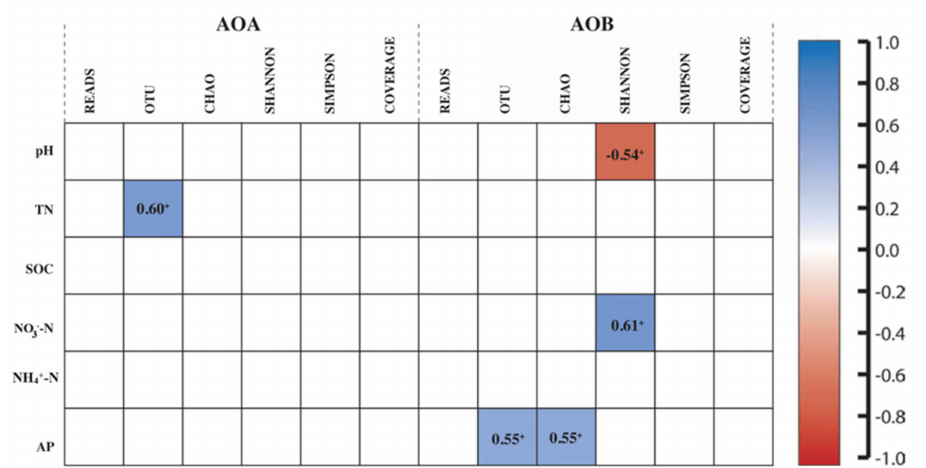
Figure 4. Correlation coefficients between dominant functional diversity of AOA, AOB, and physio- chemical soil properties. Abbreviations: Soil pH; TN, Total Nitrogen; SOC, Soil organic carbon; NO 3 − -N, Nitrate; NH 4+ -N, Ammonium N; AP, Available Phosphorous. OTUs: observed number of OTUs; Chao1: Chao1 richness index; Reads; Shannon: Shannon functional indices; Simpson: Simpson index; and Coverage. Within the cells, p values (r) between variables are plotted. Only the strongest associations are displayed. * Significant correlations are indicated at p <